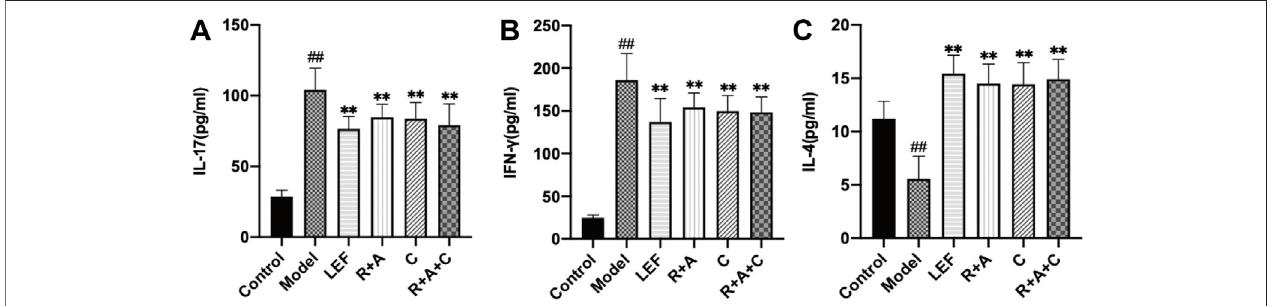
FIGURE8| ThelevelsofIL-17,IFN- γ ,andIL-4ofcontrolandCIAmiceafterdrugtreatment. (A) ThelevelsofIL-17. (B) ThelevelsofIFN- γ . (C) ThelevelsofIL-4.The results are presented in a bar chart. Data are presented as mean ± SD ( n = 8); # p < 0.05, ## p < 0.01, compared with the normal group; * p < 0.05, ** p < 0.01, compared with the model